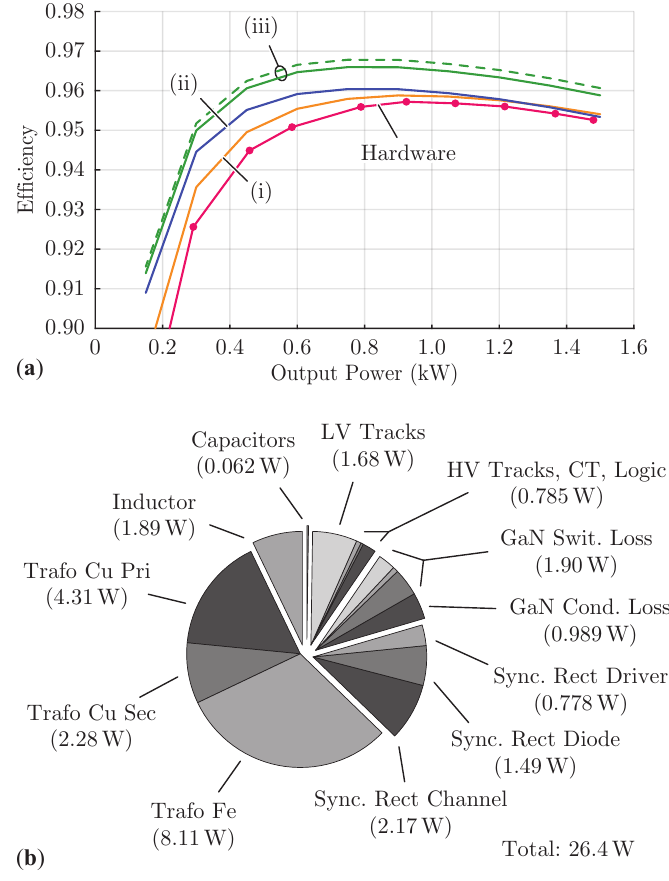
Figure 18. ( a ) Calculated efficiencies (i,ii,iii) as result of a series of improvements for comparison with the prototype’s measured efficiency (“Hardware”): (i) larger limb and yoke cross-sectional areas for reduced core losses; (ii) new LV-side switch ( IQE013N04LM6 ) with lower gate charge and triggered by a lower gate voltage using an LDO (6V instead of 12V); and (iii) 50% lower body-diode conduction time (dashed line shows the ideal case of no body-diode conduction). ( b ) Loss budget of case (iii) at 50%